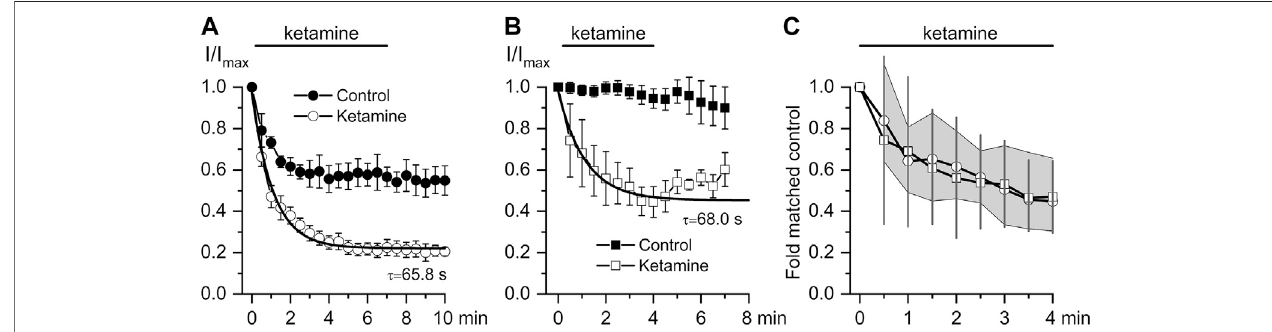
FIGURE 4 | Comparison of ketamine action on mI CAT evoked by CCh or GTP γ S. (A , B) Time courses of average normalized 50 μ M CCh-induced mI CAT (a, n (cid:2) 8) and 200 μ M GTP γ S-activated mI CAT (b, n (cid:2) 6) in control (closed circles), during ketamine (100 μ M) application (open circles) and after its wash-out. Superimposed smoothlinesshowsingleexponential fi tofthedatapointswiththetimeconstantvaluesindicated(Mann – WhitneyTest: p < 0.05forboth). (C) Quanti fi cationofthedegree and kineticsofmI